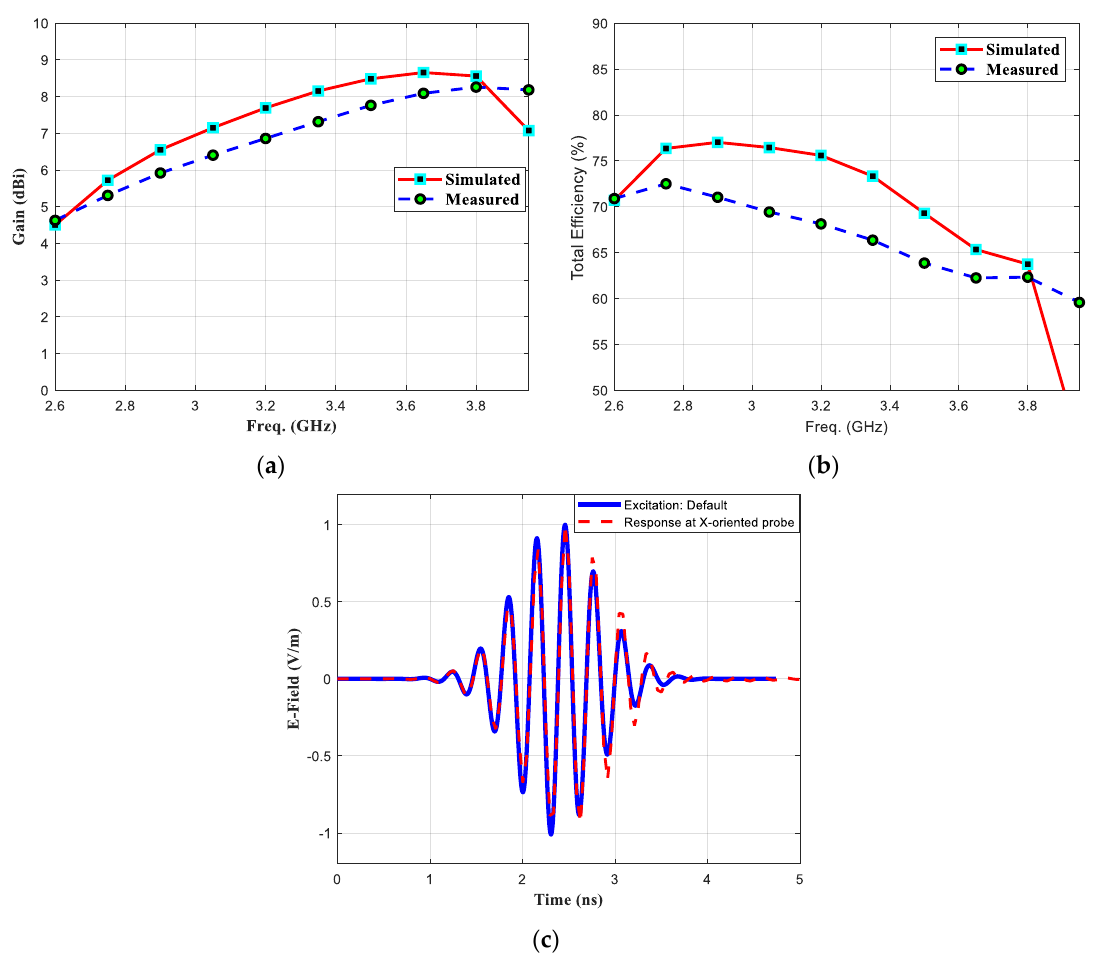
Figure 11. Proposed Antenna’s ( a ) Gain vs. frequency ( b ) % efficiency vs. frequency and (c) time- Figure11. ProposedAntenna’s( a )Gainvs. frequency( b )%e ffi ciencyvs. frequencyand( c )time-domain domain excitation response received by the x-oriented probe. excitation response received by the x-oriented